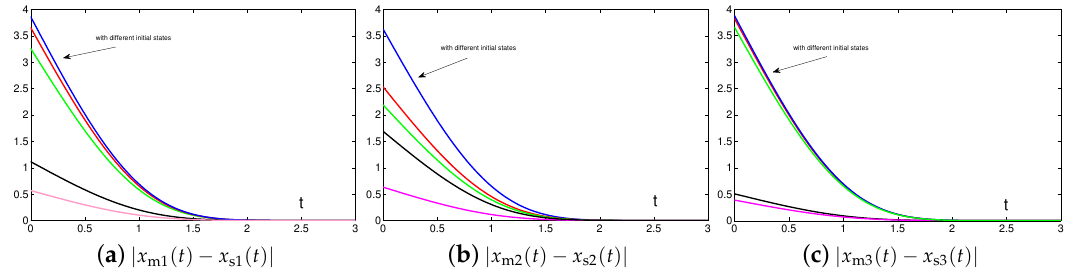
Figure 14. Absolute errors between two identical Lu chaotic systems (27) and (28) equipped with controller (6) via the proposed SEZN approach using randomly generated initial